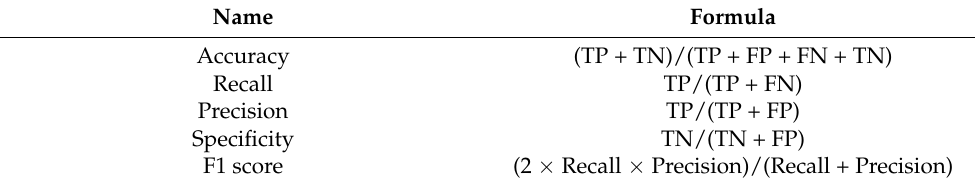
Table 1. Summary of the most commonly used evaluation metrics of the reviewed